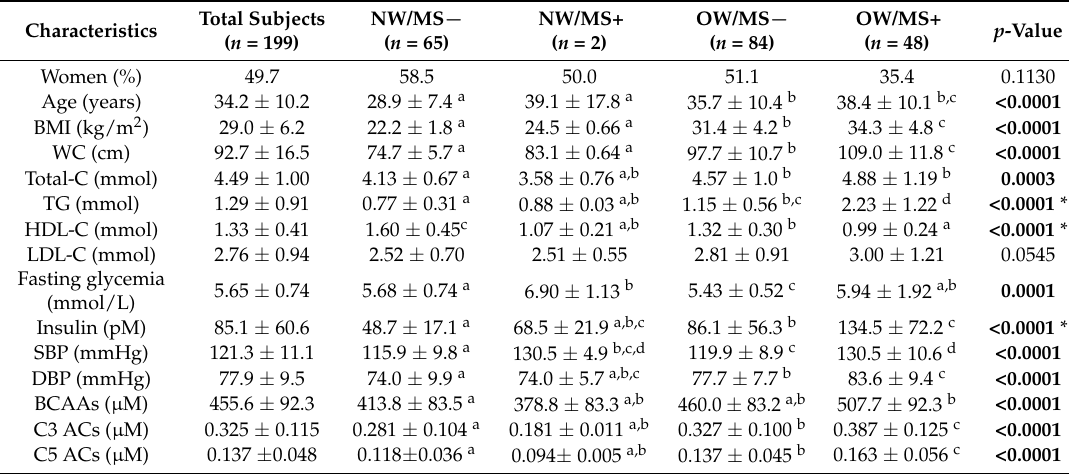
Table 1. Characteristics of participants.